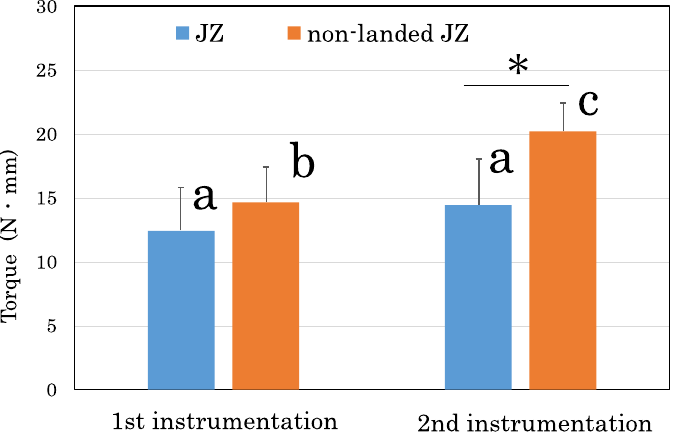
Figure 4. Maximum values of torque during root canal instrumentation. Data represent the mean and standard deviation ( n = 10). * p < 0.05 within the same instrumentation sequence. Different lowercase letters are significantly different within the same instrument ( p < 0.05).